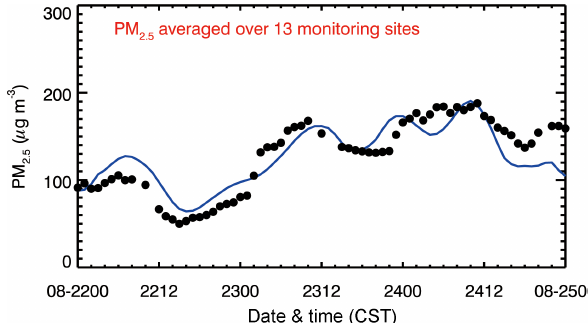
Figure 13. Comparison of measured (black dots) and simulated (blue line) diurnal profiles of near-surface hourly PM 2 . 5 averaged over all ambient monitoring stations from 22 to 24 August